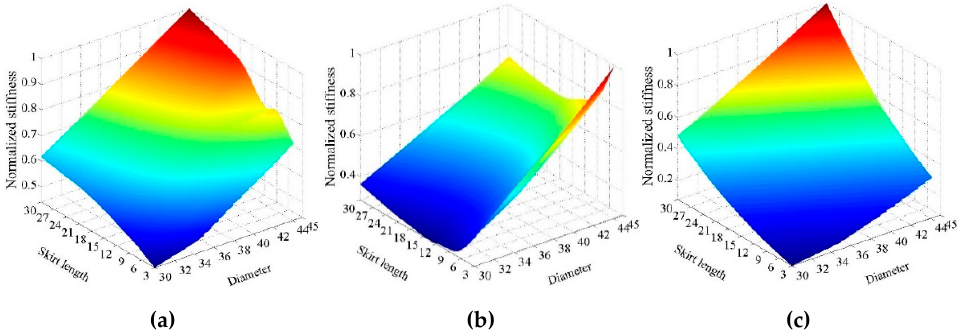
Figure 18. Variation of three dynamic stiffness coefficients at dimensionless excitation frequency of 0 and 2: ( a ) Horizontal stiffness; ( b ) coupling stiffness; ( c ) rocking stiffness.